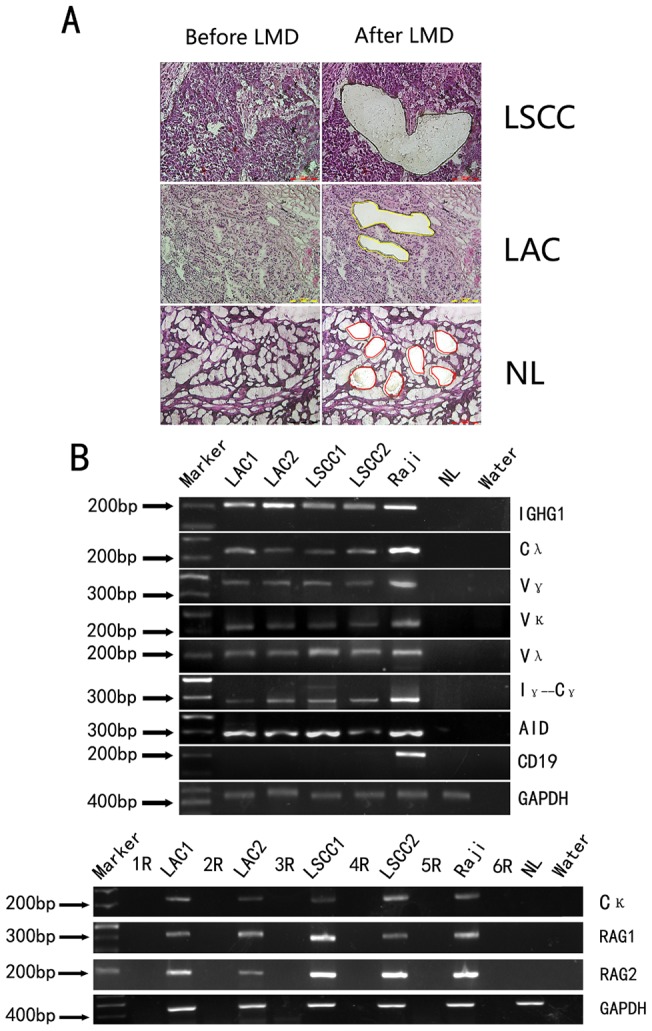
IgG expression in lung cancer tissue with LMD coupled with RT-PCR.
A is the representative photos of LMD in LSCC, LAC and normal lung adjacent to tumor mass. B, the bands represented that IgG synthesis associated genes were detected in LSCC, LAC and normal lung with LMD coupled with RT-PCR. No CD19 was detected, thereby excluding possible B lymphocyte contamination. Raji cell line was used as a positive control. Water was used as a negative control in place of the primers. RNA treated with DNase (abbreviated as R) was used as a template to exclude possible false positivity in 1R-6R. NL is the abbreviation of normal lung.